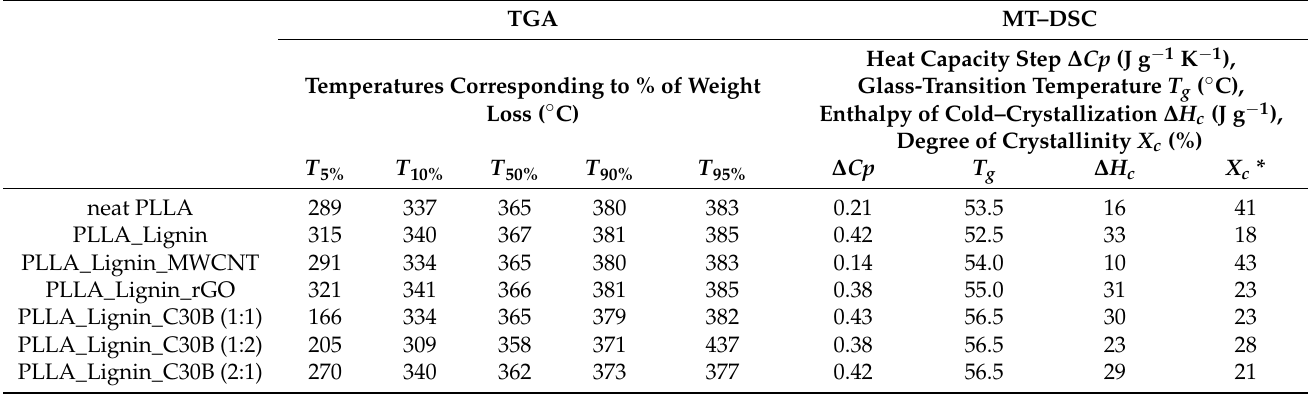
Table 1. TGA and MT-DSC heat-only extracted